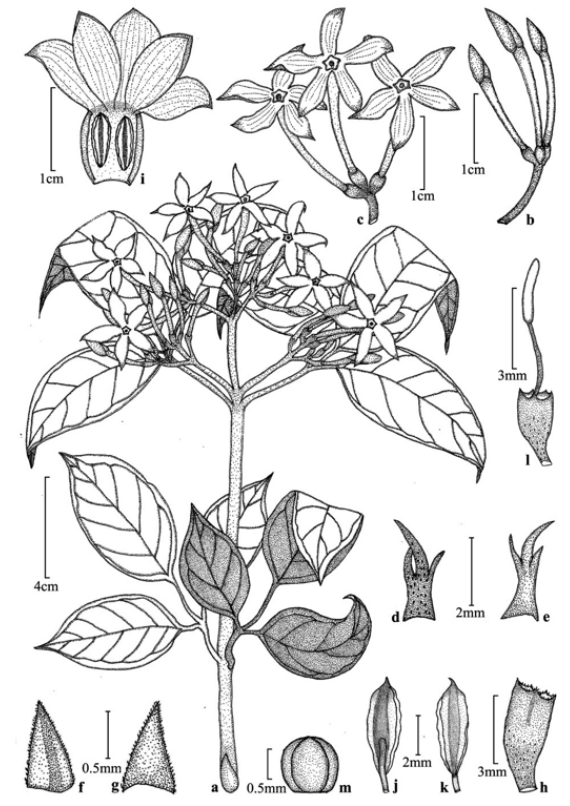
Figure 3. Jasminum lanceolaria Roxb.: a—flowering twig | b—bud | c—floret | d—bract (abaxial view) | e—bract (adaxial view) | f— bracteole (abaxial view) | g—bracteole (adaxial view) | h—calyx | i—corolla showing epipetalous stamens | j—stamen (abaxial view) | k—stamen (adaxial view) | l—gynoecium | m—ovary.